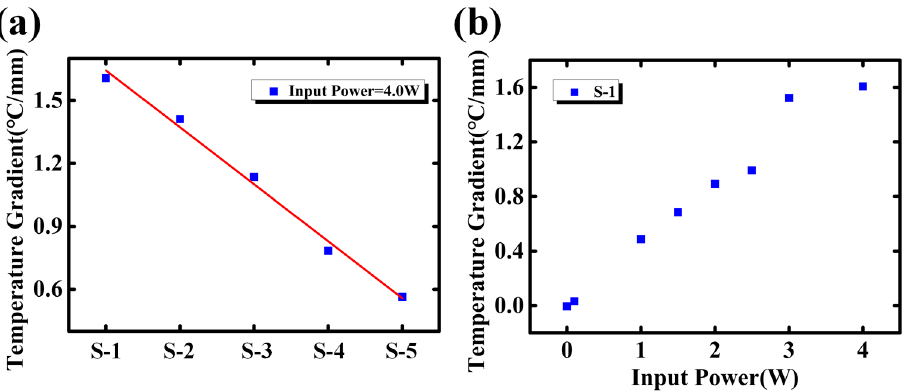
Figure 9. Temperature and temperature fluctuation change of CDW from inlet to outlet (S-1 to S-5) when flow rate is 50 mL/h and the input power is 4.0 W. Figure 10. ( a ) Temperature gradient changes along the microchannel (S-1 to S-5); and ( b ) temperature Sensors 2018 , 18 , x gradient changes with different input power.